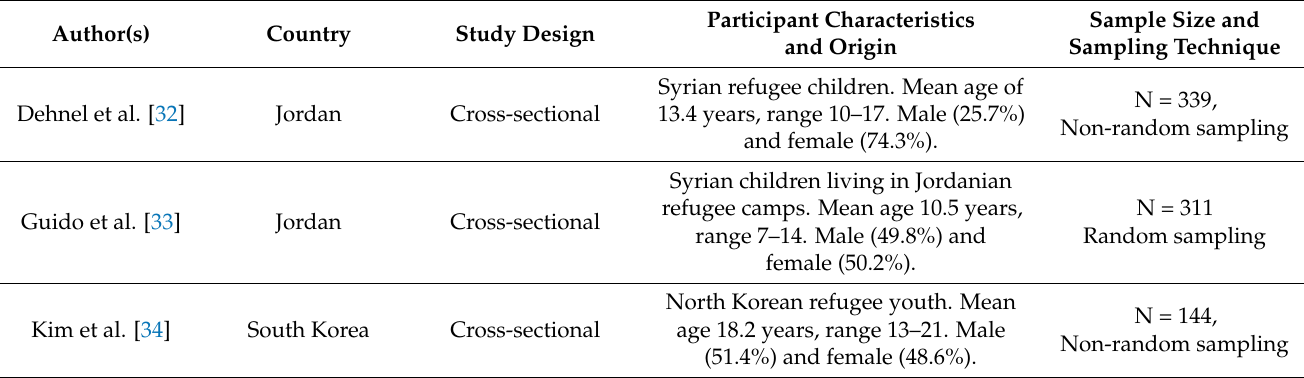
Table 1. Description of included Studies Demographic